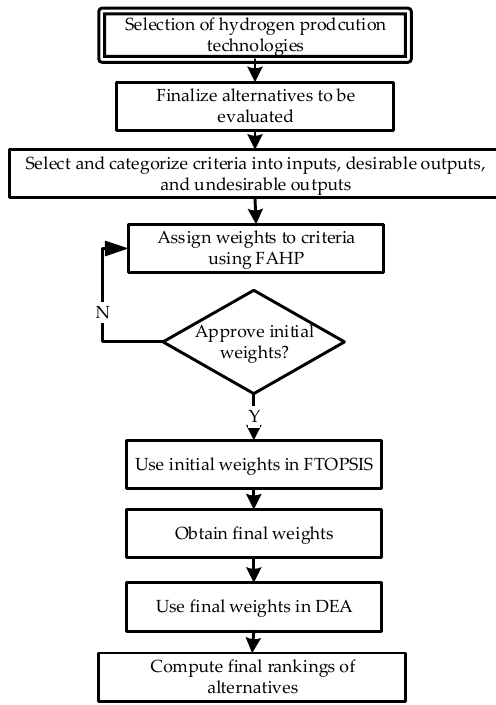
Figure 1. Flowchart of research design.